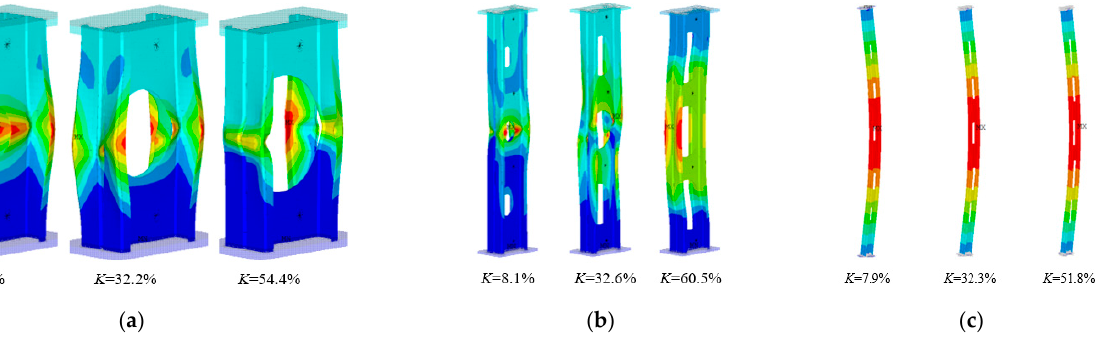
Figure 18. Failure modes of the combined columns with different opening ratios ( a ) L300; ( b ) L1500; ( c ) L3000.